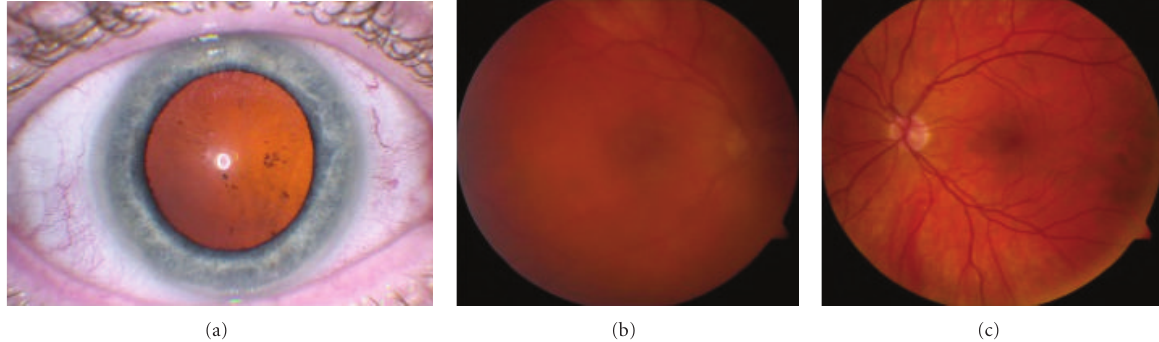
Figure 1: Photographs at initial presentation. (a) Slit lamp photography demonstrates deposits on the anterior lens surface of the right eye. (b) Fundus photography of the right eye shows vitreous debris without other posterior segment abnormalities. (c) Fundus photography of the left eye is